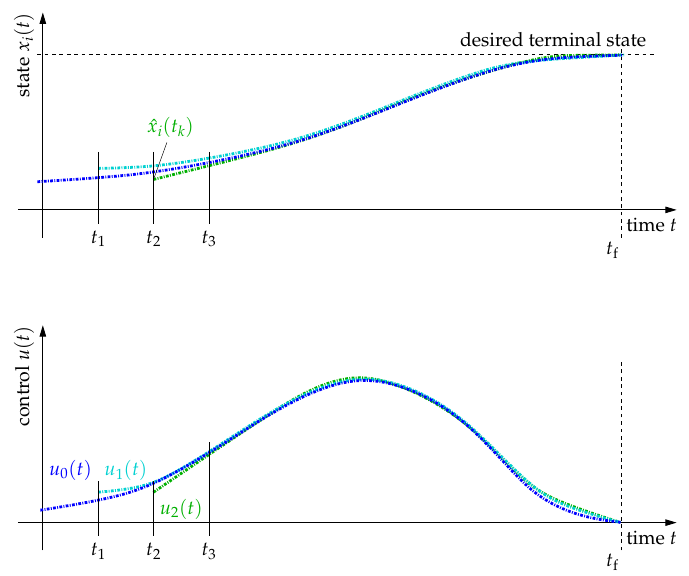
Figure 3. Re-computation of the optimal control sequences u k ( t ) for the reduced horizons [ t k ; t f ] , k ∈ { 0, . . . , K c } , with the associated predicted state trajectories x i , k ( t ) , i ∈ { 1, . . . , n } , initialized with the state estimates ˆ x i ( t k )